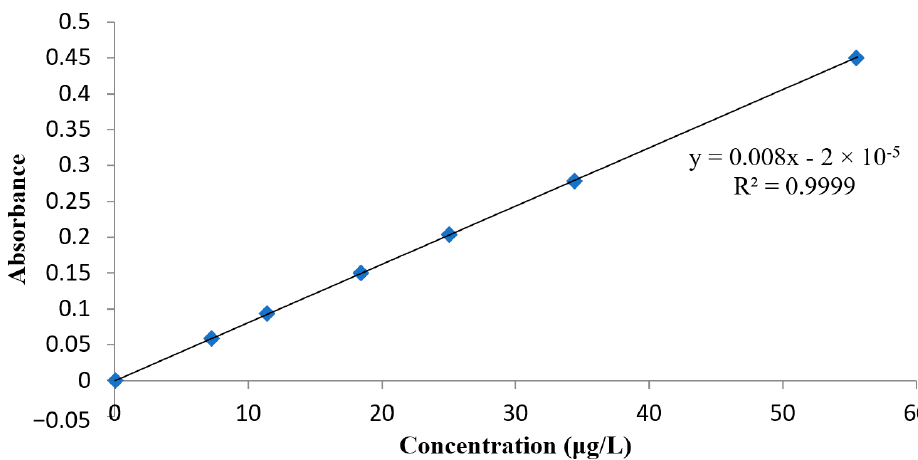
Figure 3. Calibration curve for arsenic standards. Table 4. The linearity and the uncertainty of the calibration curve threshold (Figure 3).